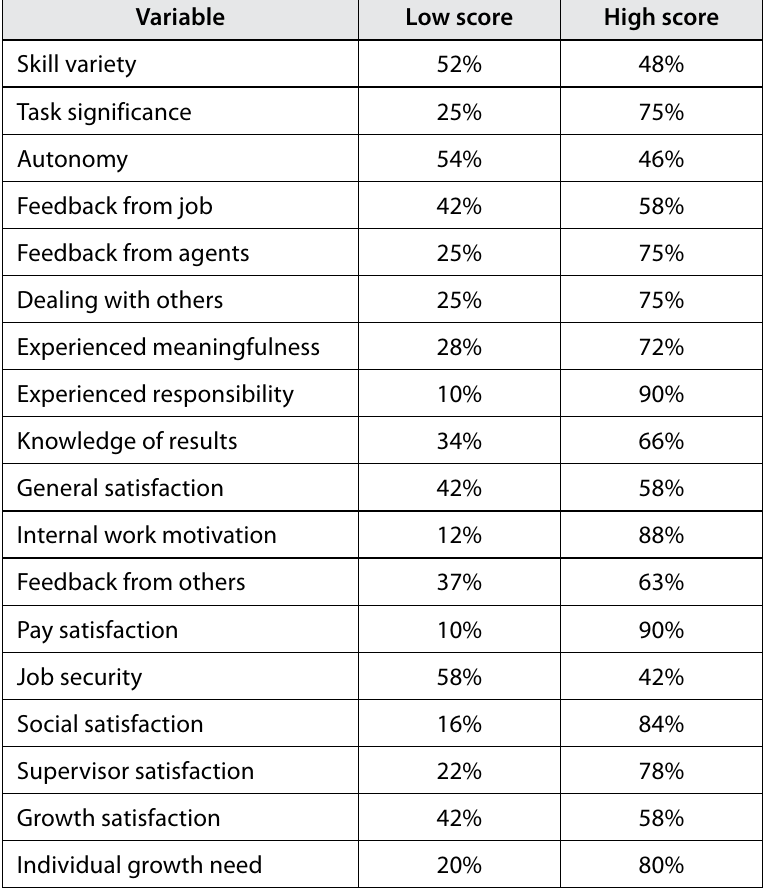
Table 2 Percentage